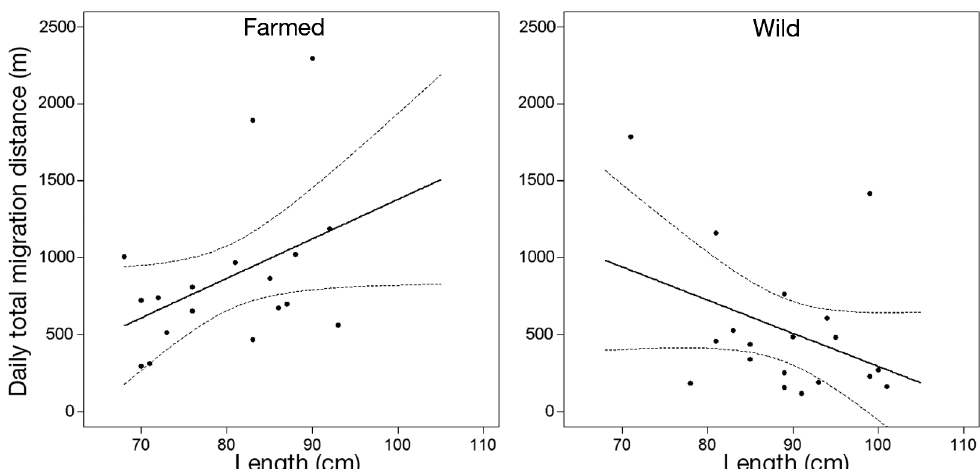
Fig. 6. Predicted (solid line) daily total movement distance of Atlantic salmon Salmo salar plotted as a function of body length and origin, showing upper and lower 95% CI (dotted lines). Dots: observed values. The predictions were retrieved from the linear model provided in Table 1. N = 19 wild and 18 farmed Atlantic